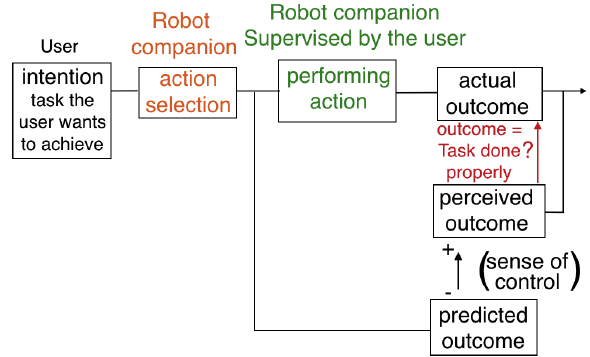
Figure 1: How perception of control is being studied in this paper